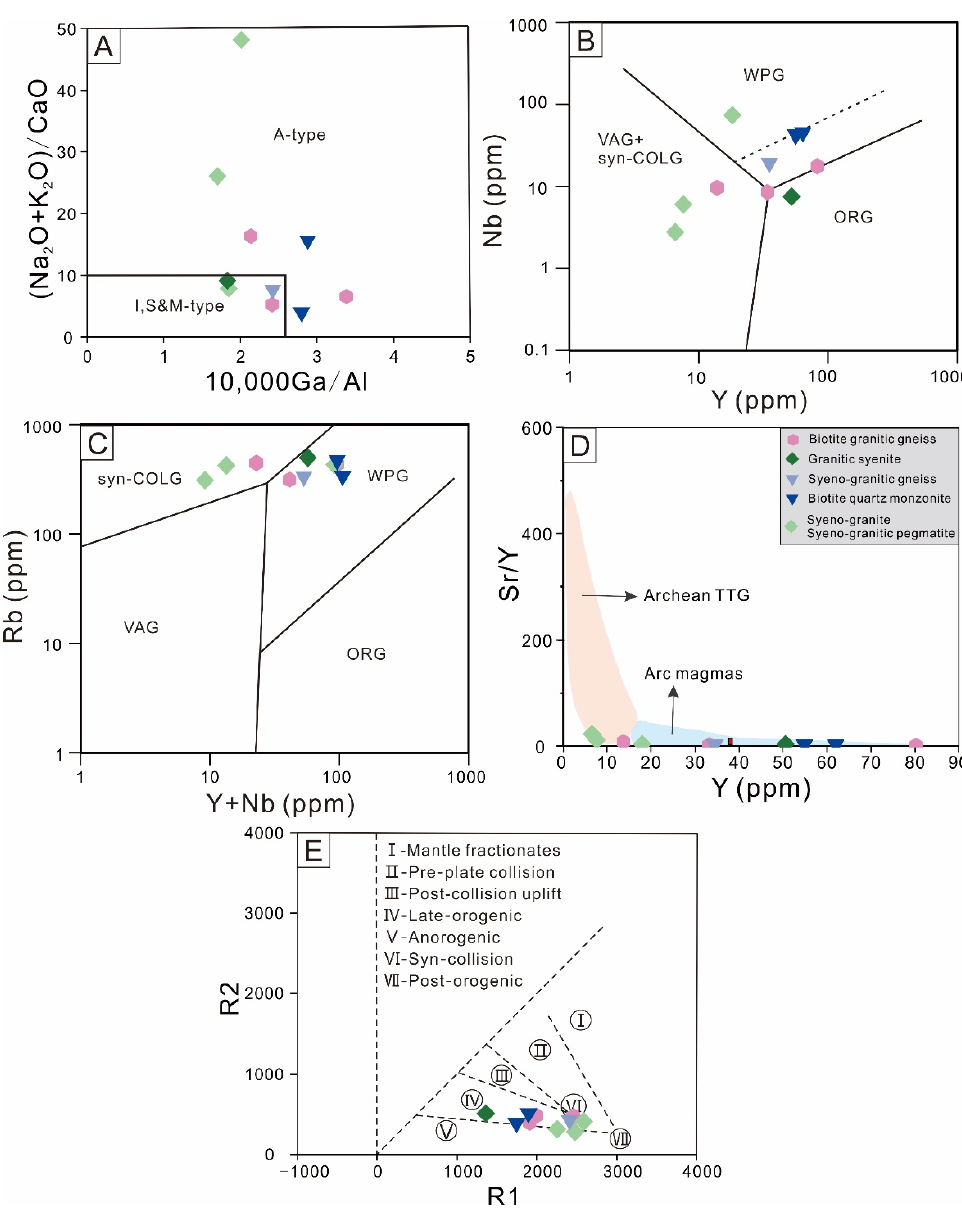
Figure 11. Petrogenetic discrimination diagrams ( A ) (Na 2 O + K 2 O)/CaO-10,000Ga/Al [55]; ( B ) Nb-Y and ( C ) Rb-Y + Nb [44], ( D ) Sr/Y-Y [56], ( E ) R1-R2 cationic plot [57]. Abbreviations: VAG: Volcanic-arc granites, syn-COLG: Syn-collisional granites, WPG: Within plate granites, ORG: Ocean-ridge granites.